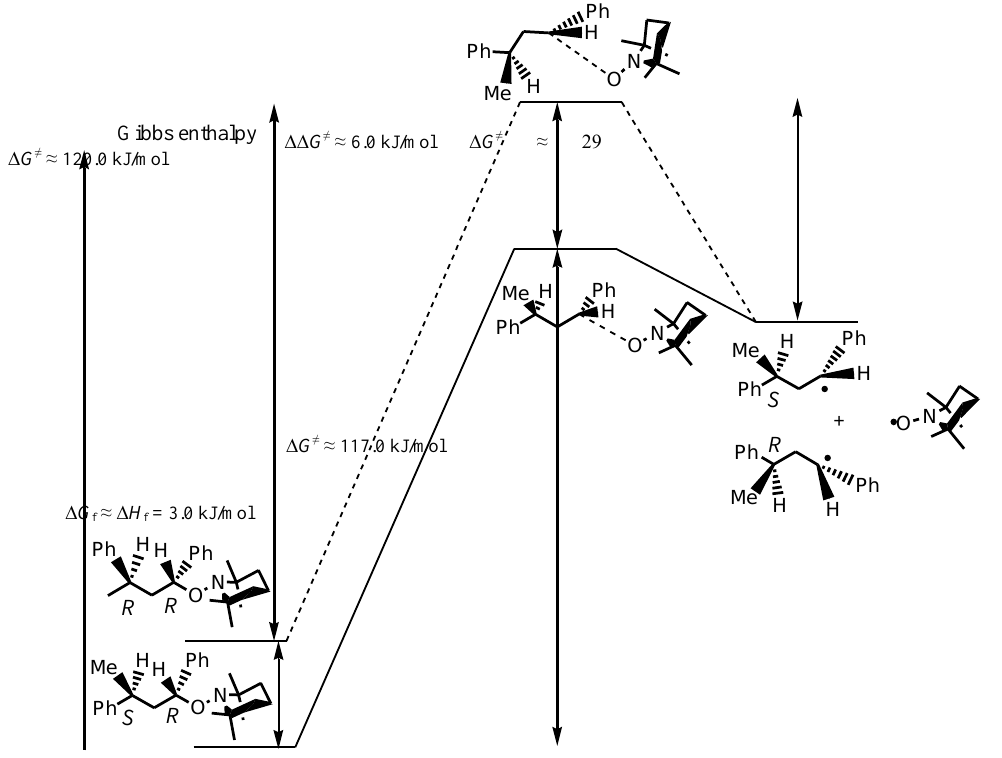
Figure 6. Pathways and expected TS [32] for the homolysis of 2 and 3